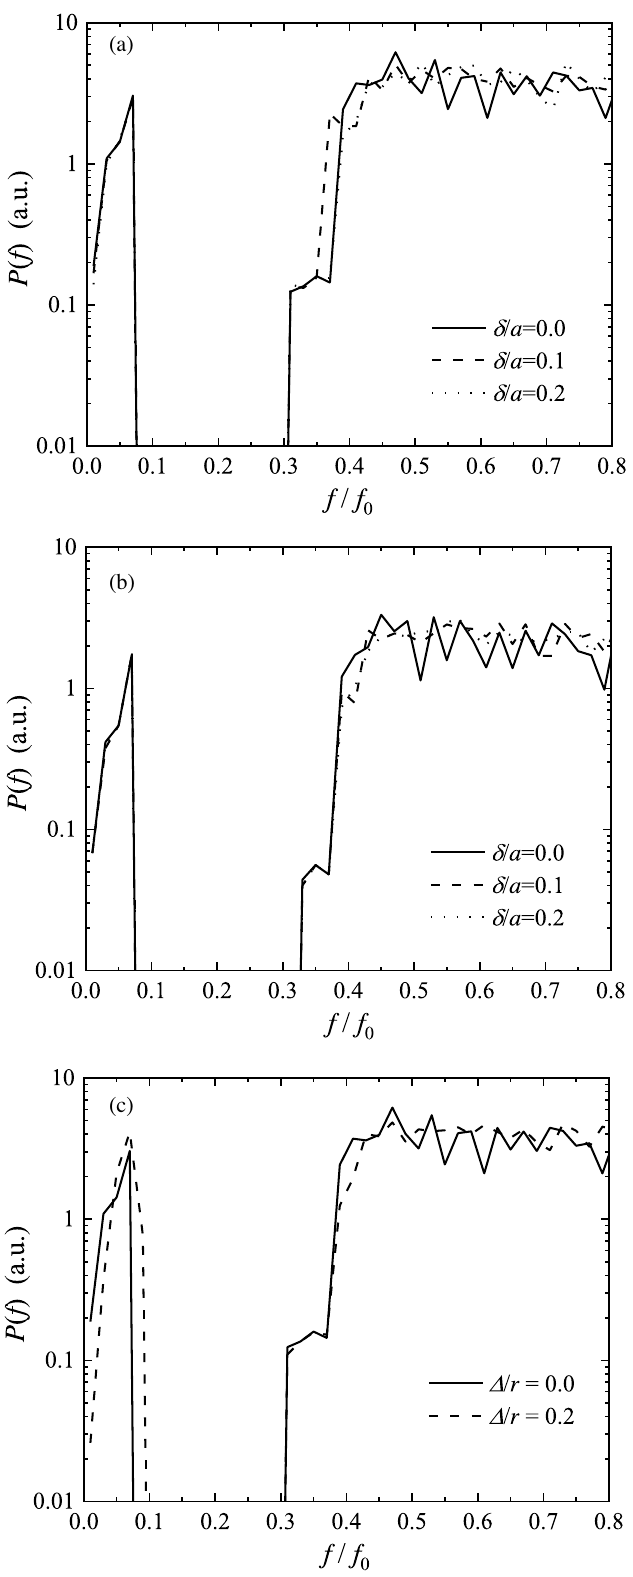
Fig. 3. Power spectrum, P ( v ), for 2DMPC composed of circular rods: (a) square lattice with positional disorder, (b) triangular lattice with positional disorder, and (c) triangular lattice with size